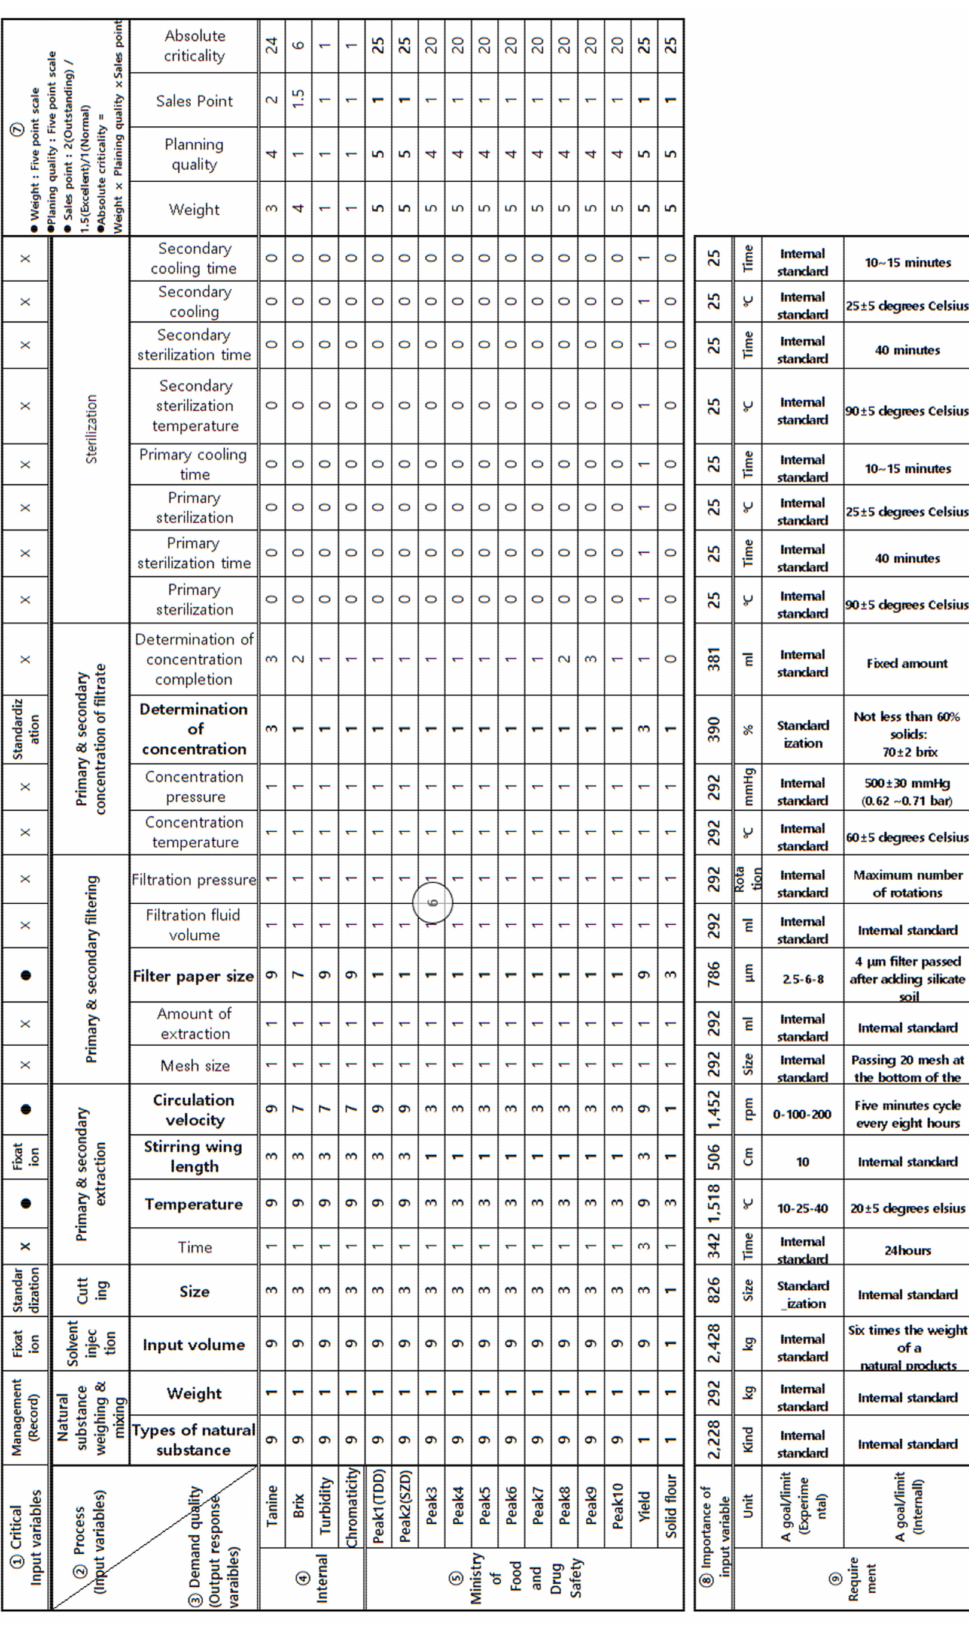
Figure 2. Quality function deployment (QFD) analysis